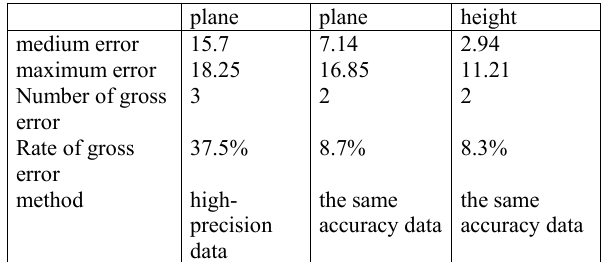
Figure 6. Errors of elevation accuracy in field 2